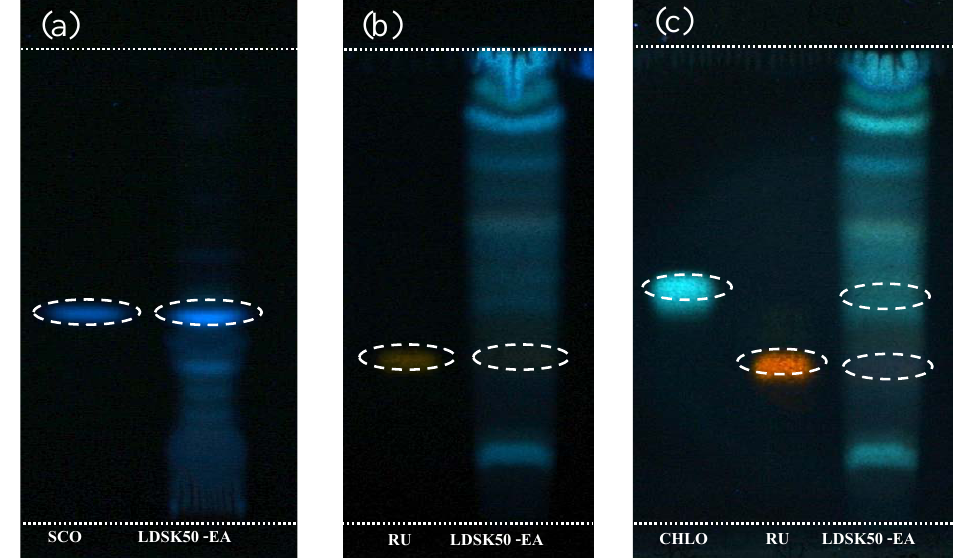
Figure 6. Thin Layer Chromatography (TLC) analysis of LDSK50-EA (fractions of 50% ethanol extract of the L. domesticum skin followed by ethyl acetate (EA) fractionation) fraction detected with Natural Product/polyethylene glycol (NP/PEG) spray reagent (366 nm) and against phytochemical standards including scopoletin (SCO), rutin (RU), and chlorogenic acid (CHLO). ( a ) toluene:ethyl acetate:formic acid (5:4:1) system; ( b ) and ( c ) ethyl acetate:formic acid:acetic acid:water (137:11:11:26) system. TPC Amount